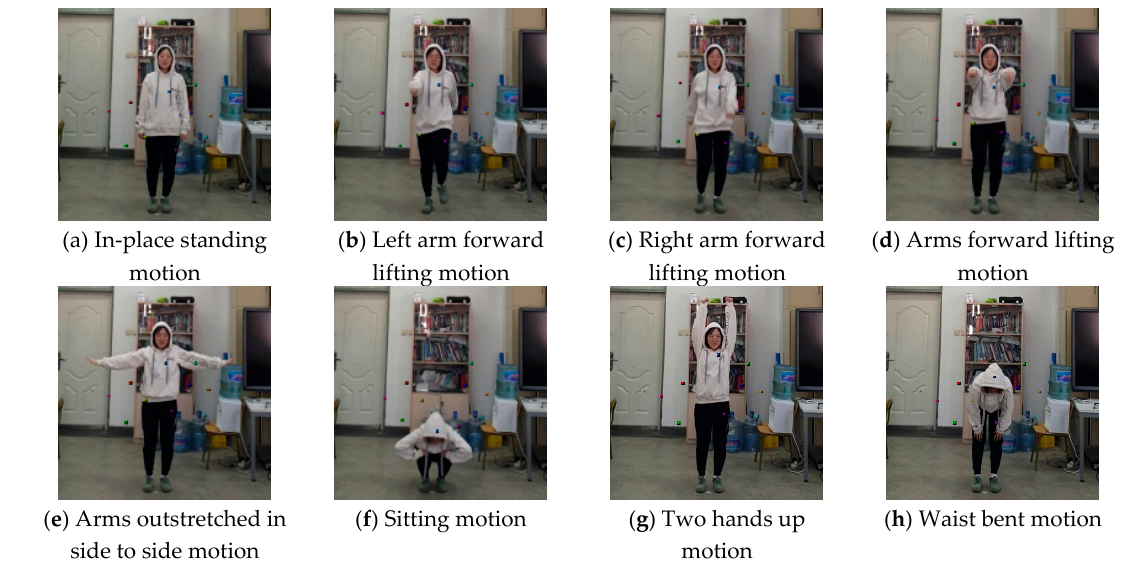
Figure 16. 2D landmarks generated when κ was 10.